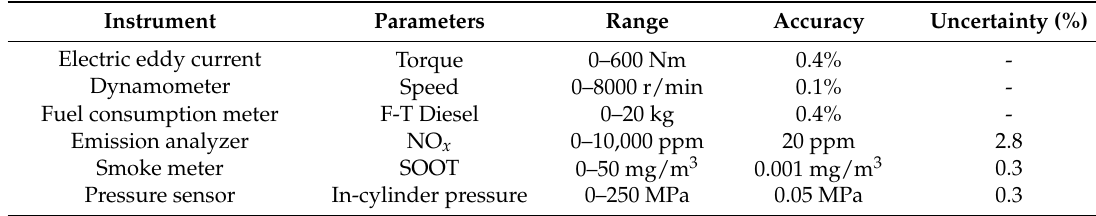
Figure 1. Test bench setup. ECU: Electronic Control Unit; F-T: Fischer-Tropsch Table 2. Accuracy and uncertainty of the measuring equipment. F-T: Fischer-Tropsch.